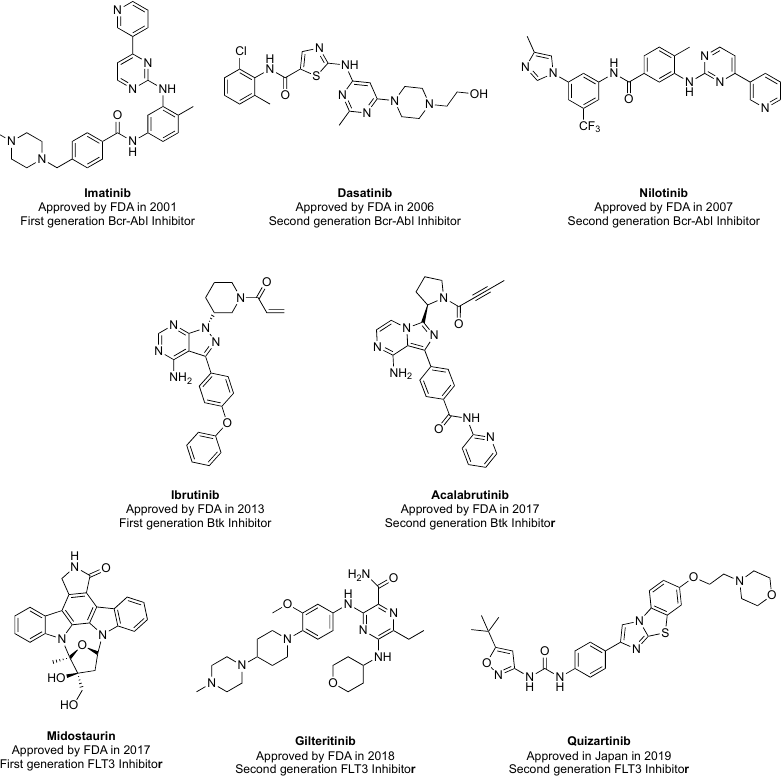
Figure 1. Chemical structures of some TKIs used in the treatment of leukaemia.